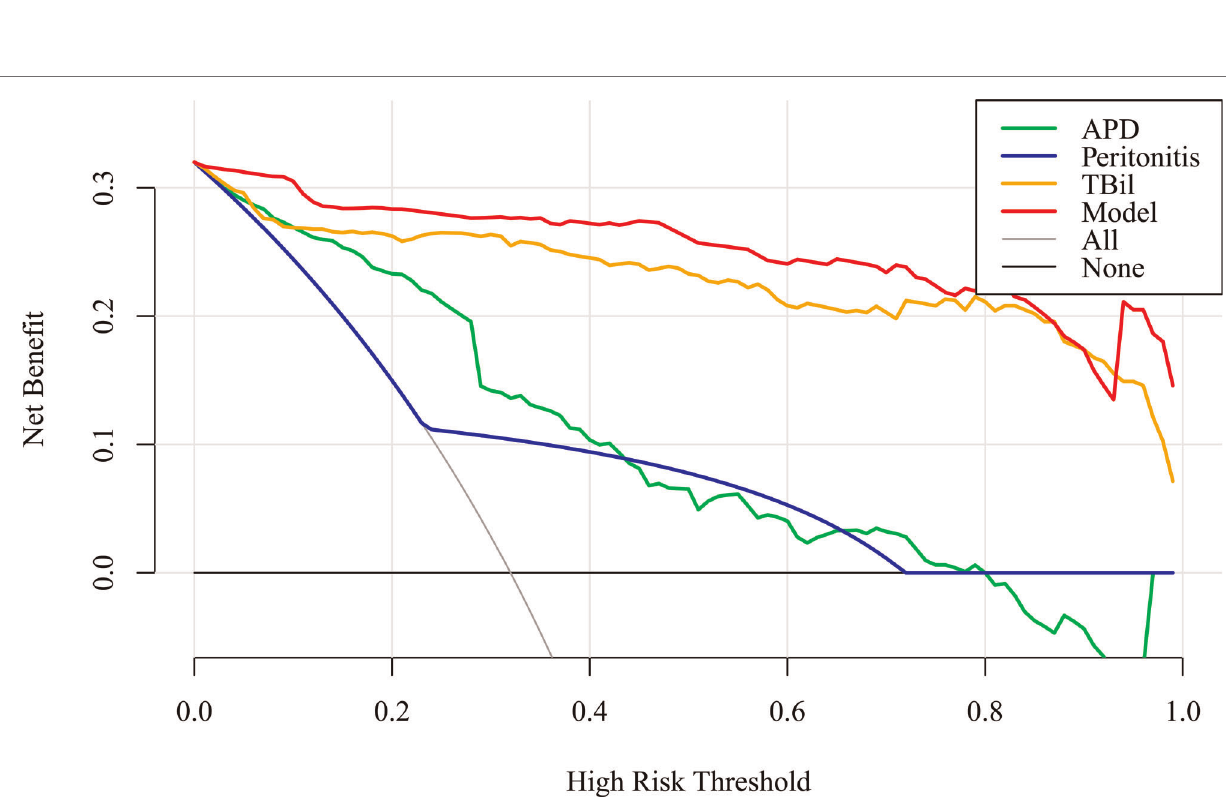
FIGURE 5 | Decision curve analysis of the nomogram for complicated appendicitis in the